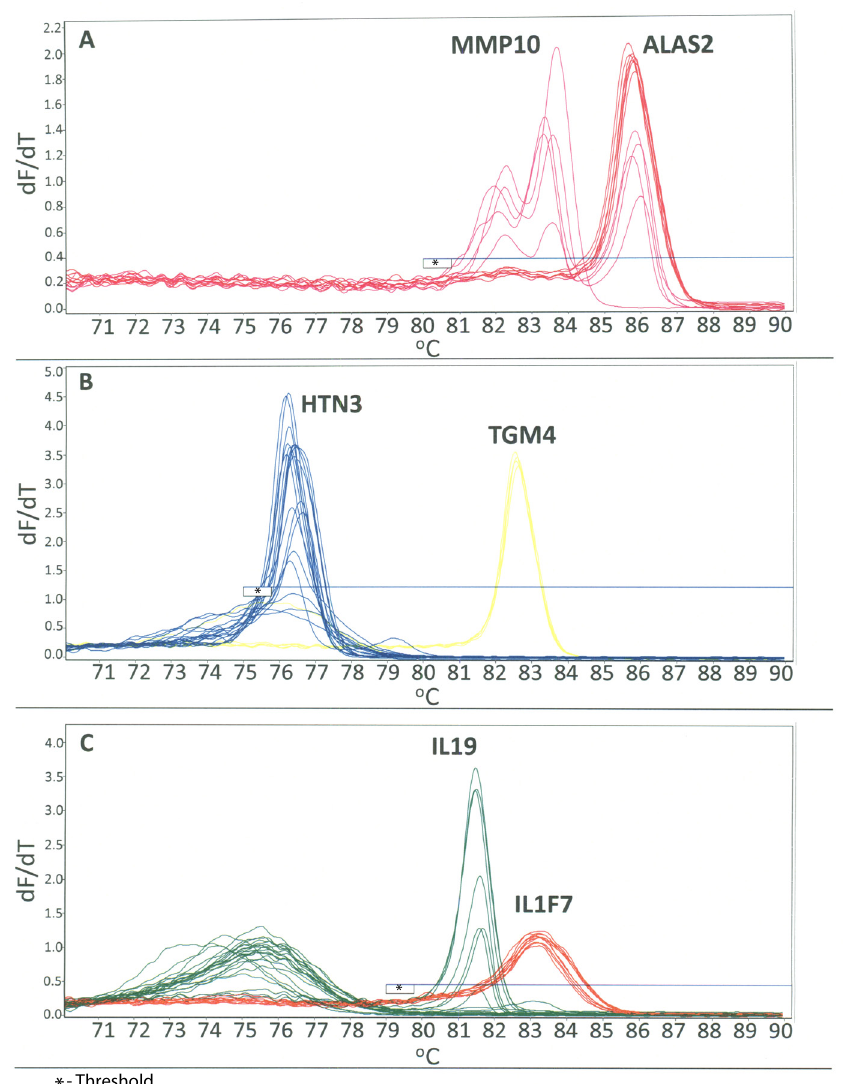
Figure 2. Duplex HRM body fluid assays. Duplex HRM assays incorporate a body fluid specific marker for each of two body fluids or tissues into a single reaction. High resolution derivative melt curve plots for the duplex assays are shown (where n = number of biological replicates (i.e. different individuals)): A ) blood/menstrual blood (respectively: ALAS2, red, n = 8; MMP10, pink, n = 5); B ) saliva/semen (respectively: HTN3, blue, n = 18; TGM4, yellow, n = 5); C ) vaginal secretions/skin (respectively: IL19, green, n = 10; IL1F7, orange, n =